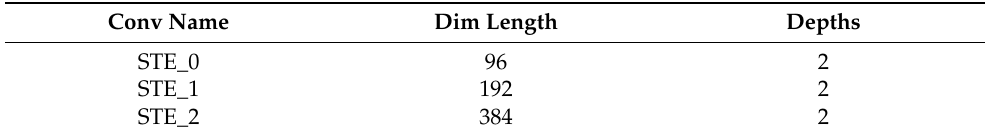
Table 1. The parameters of STE